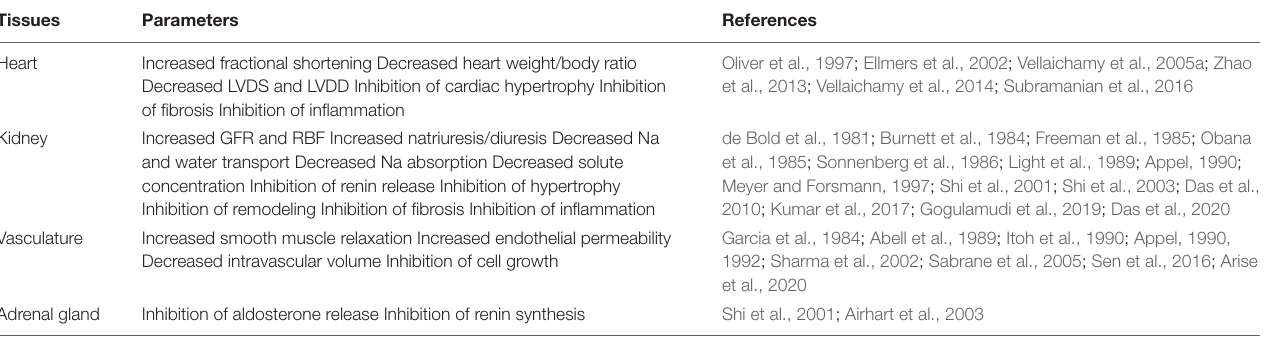
TABLE 2 | Effect of ANP-BNP/NPRA signaling in different cardiovascular target organs and tissues. Tissues